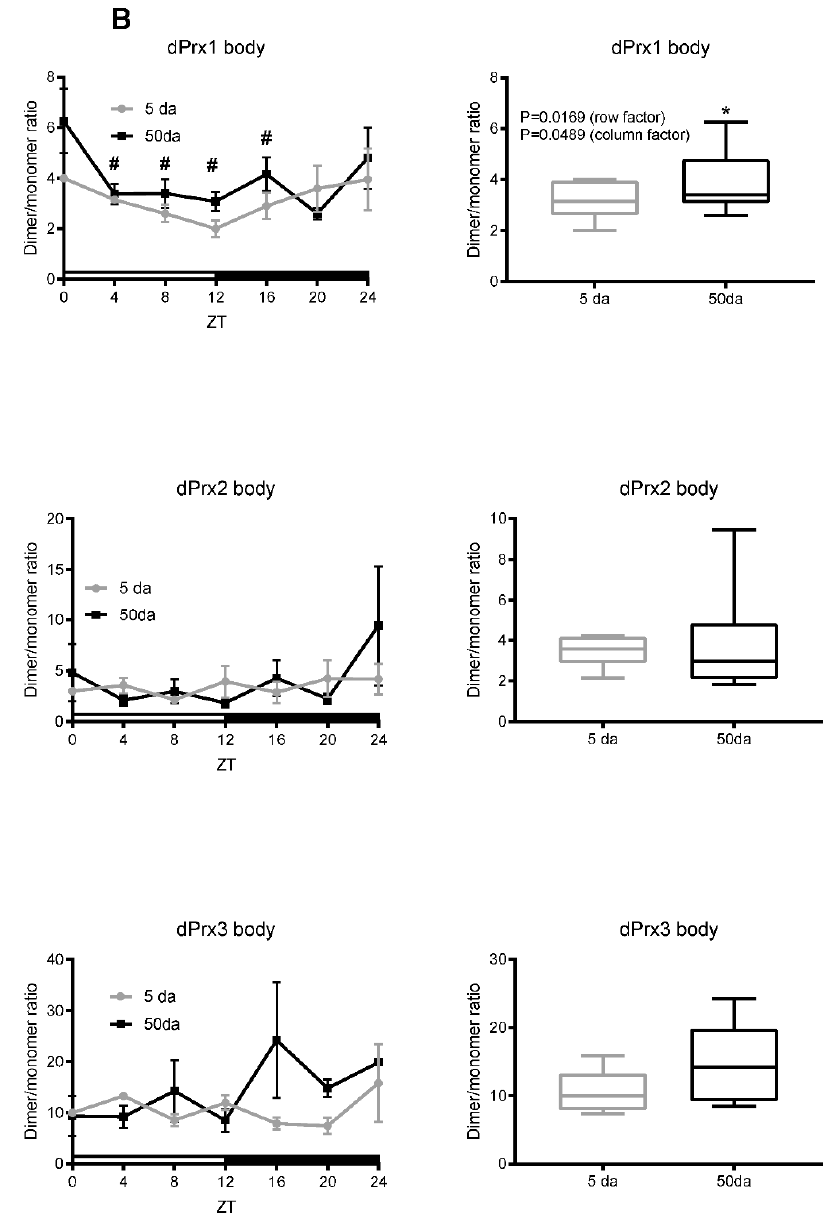
Figure 1. Analysis of the daily changes in the peroxiredoxin dimer to monomer ratio in young (5 da) and old (50 da) flies. Samples were prepared from the heads ( A ) and bodies ( B ) of Canton male flies maintained under light/dark (LD) conditions and collected for analysis at 4 h intervals. Extracts were made using a non-reducing lysis buffer, as specified in the Materials and Methods. Immunoblots were developed with antibodies specific for Drosophila peroxiredoxins 1–3. Ratios of signals corresponding to dimers and monomers are plotted on the Y axis. Zeitgeber time (ZT), where ZT0 is time of lights “on” and ZT12 is time of lights “off”, is plotted on the X axis. Data represent average values ± SEM obtained from three independent bio-replicates. Each replicate was normalized to the material collected from 5 da flies at ZT0 time point. Graphics on the right represent average 24 h dimer to monomer ratios in 5 and 50 da flies. Significance was analyzed by 2-way ANOVA with Bonferonni post-test. In the graphs shown on the left, # marks statistically significant differences between ZT0 and ZT4–24. In the graphs shown on the right, * marks a significant difference between 5 da and 50 da flies. Representative immunoblot images are shown in Figure S1.